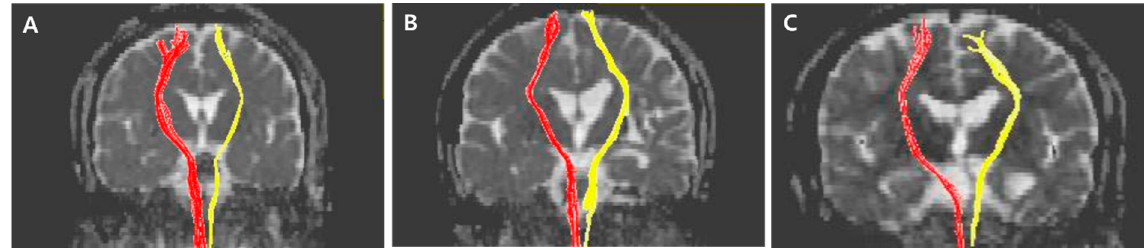
Figure 3. Representative diffusion tensor tractography images of the spinothalamic tract in typical subjects from the ( A ) CPSP, ( B ) stroke control, and ( C ) normal control groups. The non-affected tract is shown in red, and the affected tract in yellow.